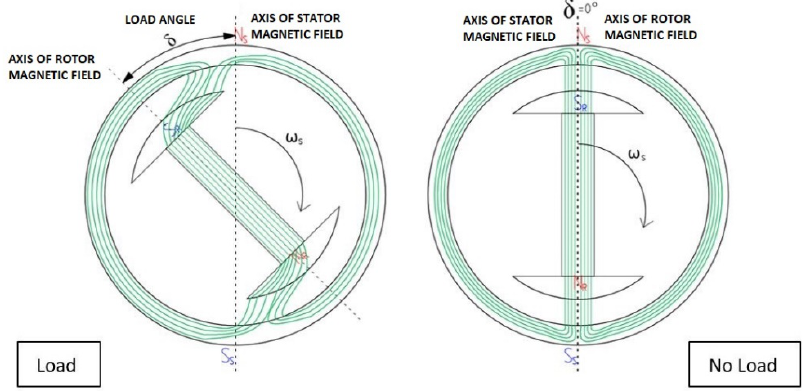
Figure 3. Graphical representation of the relation of rotor position, magnetic field and load angle.